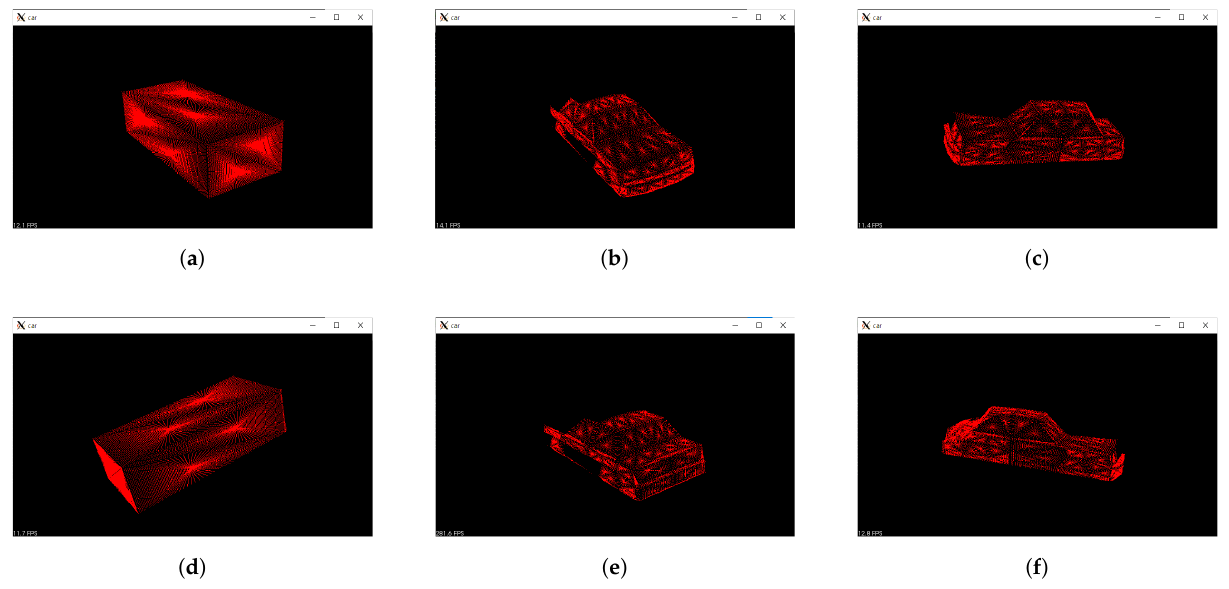
Figure 5. Examples of model point cloud data: ( a ) Model data of the front of the rectangular model. ( b ) Model data of the front of the vehicle. ( c ) Model data of the left of the vehicle. ( d ) Model data of the side of the rectangular model. ( e ) Model data of the rear of the vehicle. ( f ) Model data of the right of the